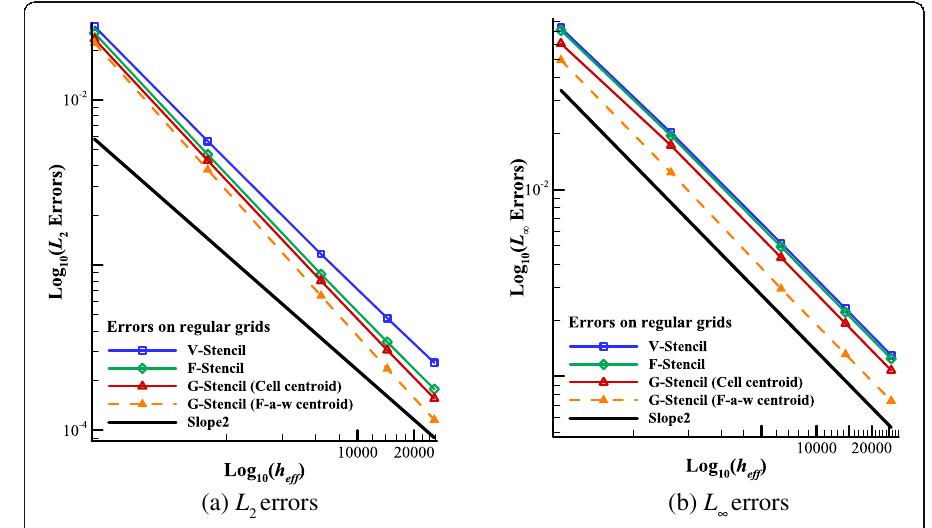
Fig. 21 ( a ) L 2 and ( b ) L ∞ errors. Errors of different stencils on regular grids with AR ≈